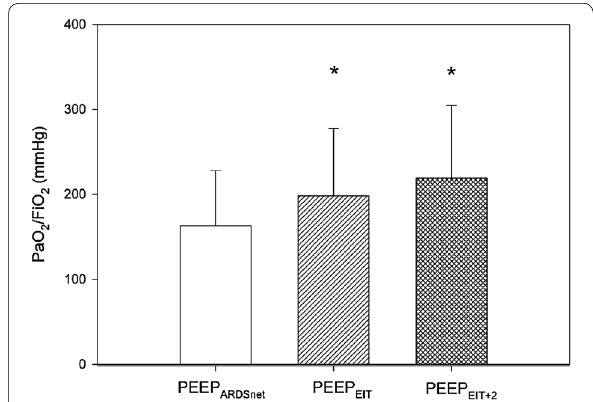
Fig. 2 PaO 2 /FiO 2 ratio in all study phases. It significantly improved in both PEEP EIT and PEEP EIT phases compared with PEEP ARDSnet . + 2 * p < 0.05 compared with PEEP ARDSnet phase